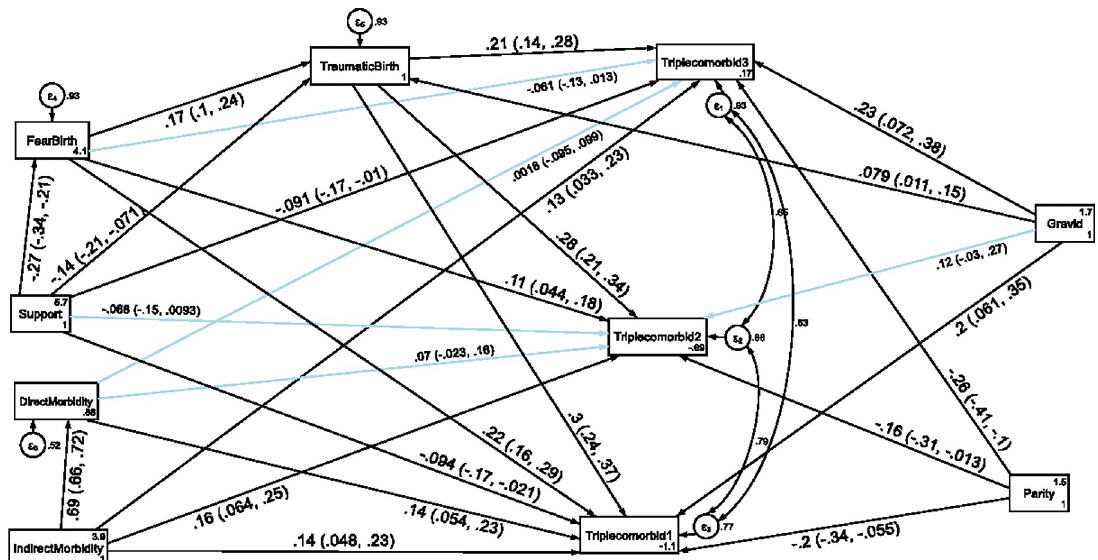
Fig 9. A structural equation model of the factors associated with triple comorbidity symptoms in postpartum women, Northwest Ethiopia. Note: β ’s are standardized estimates with 95% CI.